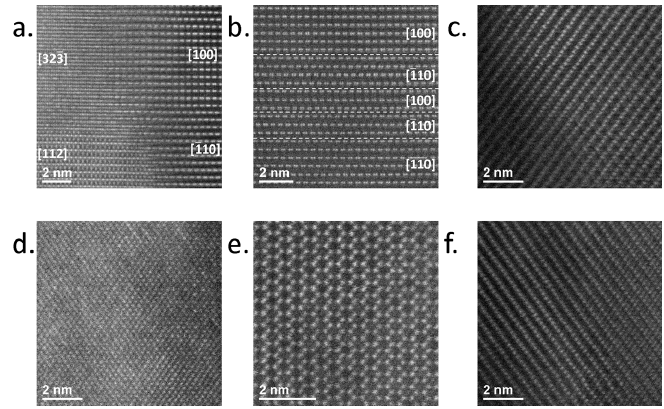
Figure 9. HAADF-STEM imaging identifying the presence of orientational variants in samples grown on both ( a , b ) STO(111) and ( c – f ) STO(100). According to HAADF-STEM images, the film is predominately in the monoclinic Li 2 (Mn,Ni,Co)O 3 phase, however occasional regions of ( a ) spinel (shown in [112] c ) were observed. In ( a , b ), the STO is oriented to [112]. In ( a ) [323 (cid:3364) ] m , [100] m , and [1 (cid:3364) 00] m variants are present. The spinel [112] c impurity is coherent with the surrounding film. In ( b ), [100] m , [1 (cid:3364) 1 (cid:3364) 0] m and [1 (cid:3364) 00] m variants are present. In ( c – f ), the STO is oriented to [110]. The following variants were observed: ( c ) [010] m , ( d ) [013] m , ( e ) [101] m , and ( f ) [01 (cid:3364) 0] m .